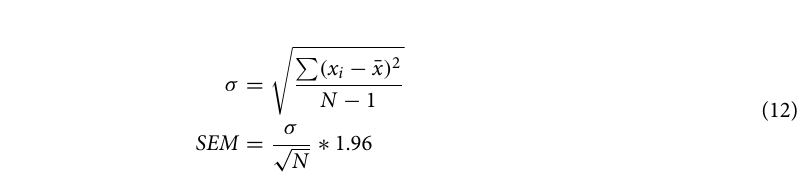
Table 2. ANOVAs’ results describing the significance of findings over the test configurations in comparison with our previous method 4 . The configurations are separated in accuracy and robustness tests. To ensure reproducibility of the p-values the following values are reported: Df = degrees of freedom, F = F-value, p = probability of the data given the null hypothesis, Sig. = p-values less than the traditional α <0.05 are marked 2 with a “*”, η = Generalized Eta-Squared measure of effect